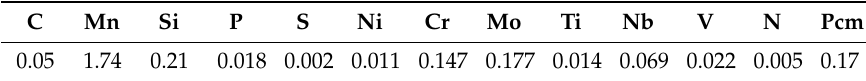
Table 1. Chemical composition (wt %) of the API X80 steel